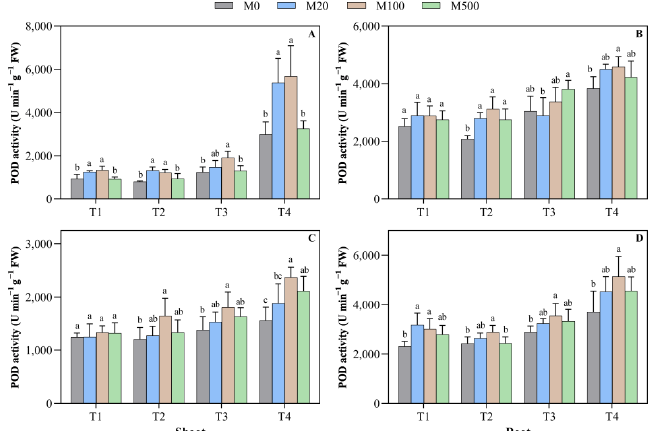
Figure 5. Effects of exogenous melatonin on the peroxidase (POD) activity of rice seed germination under high temperature stress. Means ± SEs with different letters in each parameter indicate significant statistical differences ( p < 0.05). ( A ) Peroxidase (POD) activity of shoot (7 d); ( B ) peroxidase (POD) activity of root (7 d); ( C ) peroxidase (POD) activity of shoot (9 d); and ( D ) peroxidase (POD) activity of root (9